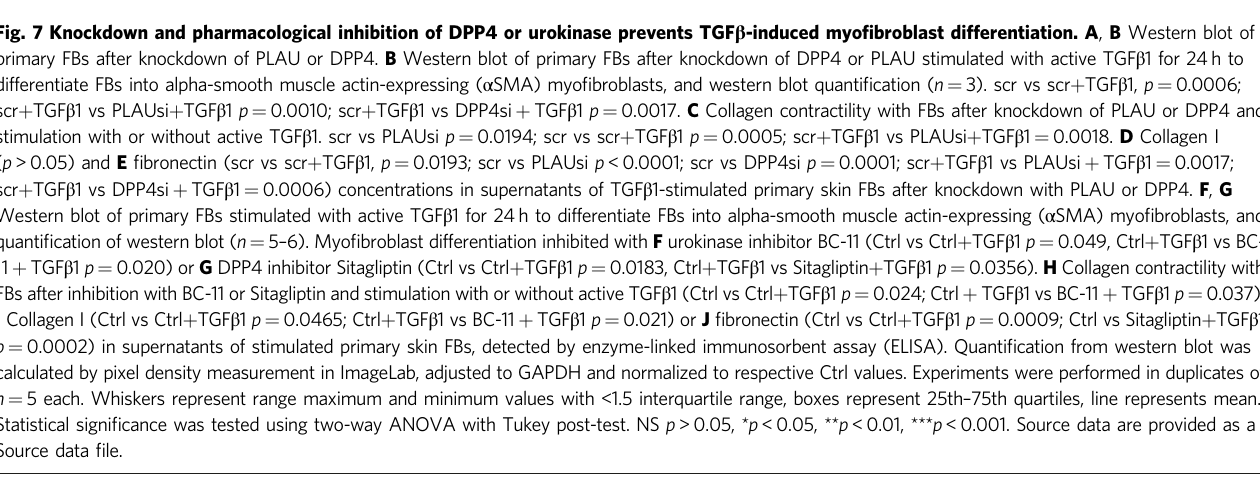
Table S1). Scars were classi fi ed as hypertrophic, pathological scars according to POSAS 70 by a plastic surgeon. Only mature scars, which had not been treated before and persisted for more than 2 years were used for all experiments. All donors had no known chronic diseases and received no chronic medication. The quality of scar tissue was assessed by histological analysis. No adjacent normal skin was observed in any of the scar samples. Healthy skin ( n = 3) was obtained from female donors between 25 and 45 years from surplus abdominal skin removed during elective abdominoplasty. Mouse full skin wounding and scar maturation . Female Balb/c mice bred at the animal facility of the Medical University of Vienna (Himberg, Austria) were housed under speci fi c-pathogen-free conditions at 22 ±2 °C room temperature and 55± 10% humidity, with 12h/12 h light/dark cycles and food and water access ad libidum. Female mice were used due to easier handling and better experimental compliance, which was necessary to enable frequent handling and application of treatment. For full-thickness skin wounds, mice were anesthetized with 100 mg/kg Xylazin and 5mg/kg ketamin (both Sigma-Aldrich, St. Louis, MO, USA) intra- peritoneally. Postoperative analgesia was provided with 0.1 mg/kg Buprenorphin (Temgesic ® , Indivior Inc., North Chester fi eld, VA, USA) subcutaneously and 0.125 mg/ml Piritramid (Janssen-Cilag Pharma, Vienna, Austria) in drinking water ad libidum. A 9× 9mm 2 area was marked on shaved backs and excised with sharp scissors. The wounds were left to heal uncovered without any further intervention. Mice were sacri fi ced 6 or 8 weeks after wounding, and scar tissues were isolated. Four-millimeter biopsies were taken from the scar tissue and analyzed individually for scRNAseq as described below. The quality of scar tissue was assessed by his- tological analysis. Samples with a maximum of 20% normal adjacent skin were used for further analyses. Serine protease inhibitor treatment . Mouse full-thickness skin wounds were induced as described above. Ultrasicc/Ultrabas ointment (1:2; Hecht-Pharma, Bremervörde, Germany) was used as carrier substance for all treatments. Four parts Ultrasicc/Ultrabas and 1 part water were mixed and used as control treatment. For protein inhibitors, Sitagliptin ( fi nal concentration 1mM) or BC-11 ( fi nal con- centration 5 mM) were dissolved in water and mixed with the ointment. Imme- diately after wounding, mice were treated with control or inhibitors by applying 100 µl ointment on each wound. After application, mice were put individually in empty cages without litter for 30 min and monitored closely to prevent immediate removal of the treatments and allow suf fi cient tissue resorption. Scabs were left intact to prevent wound infections. Mice were treated daily for the fi rst 7d, and thrice a week for 7 weeks. After scar formation, 4mm biopsies of the scar tissue were taken and cut in half. One half each scar sample was used for histological analysis, and the other biopsy halves from each treatment group were pooled and analyzed together with scRNAseq as described below.